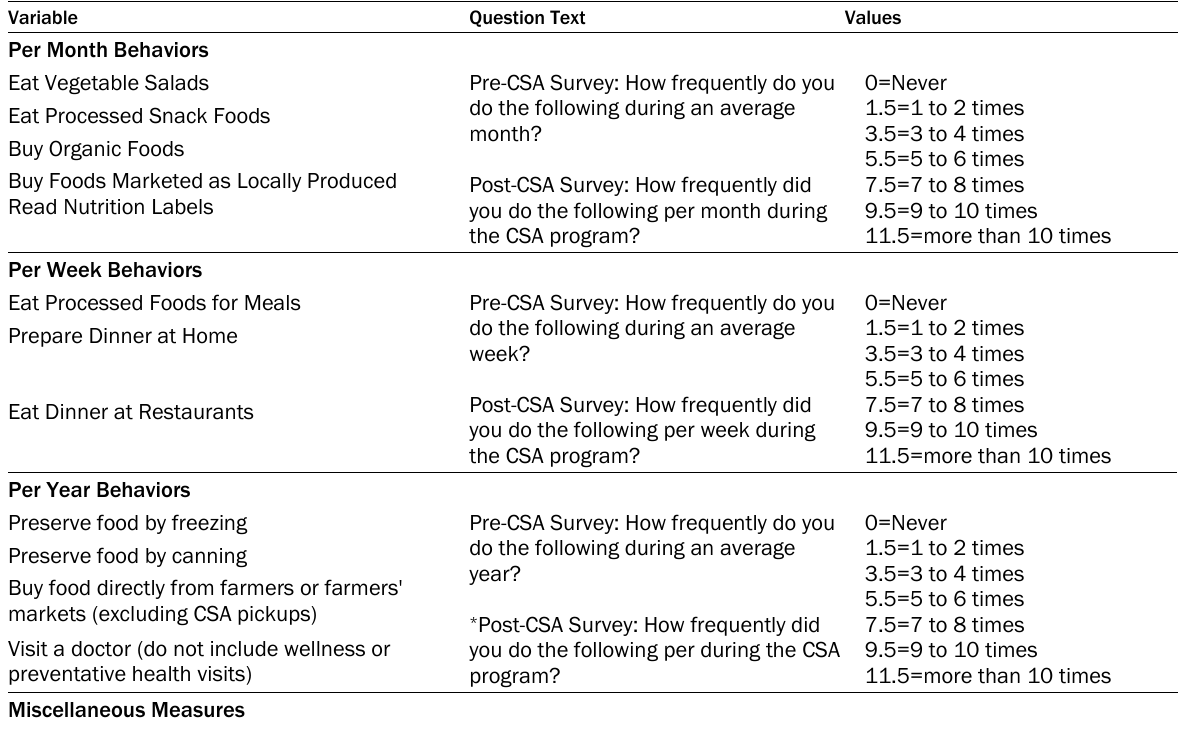
Table 1. Pre- and Post-CSA Survey Question